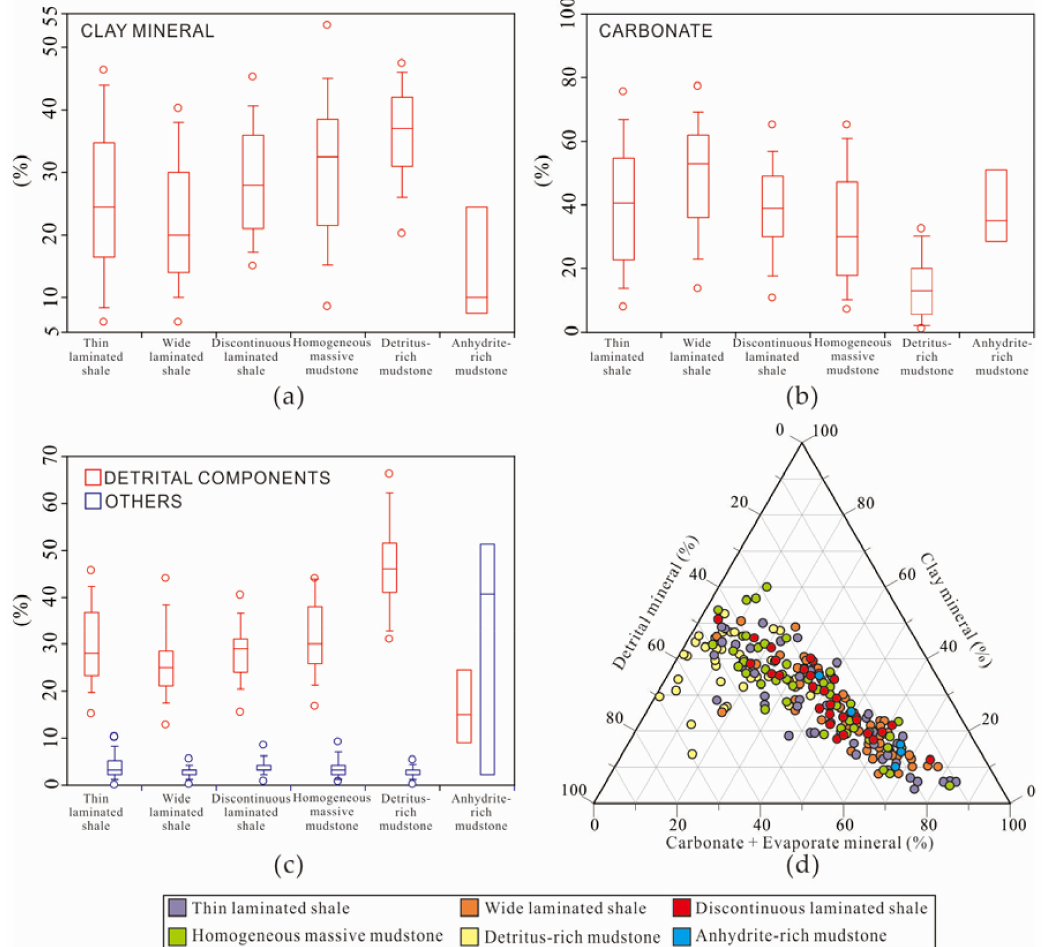
Figure 4. Mineral compositions of each type of lithofacies. ( a – c ) Box plots of different mineral compositions in various lithofacies. ( d ) Ternary diagram of the mineralogy of different